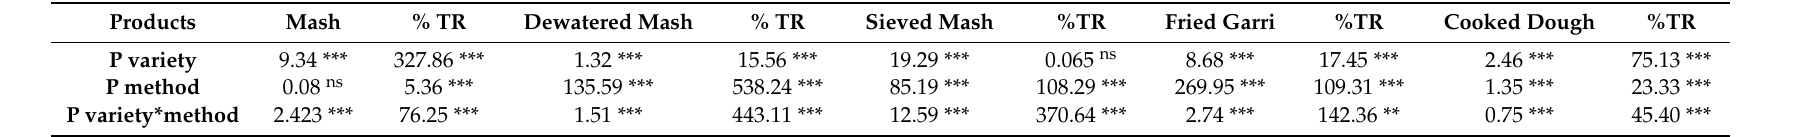
Table 3. Mean squares of statistical interaction of variety and di ff erent processing steps on β -carotene concentration and